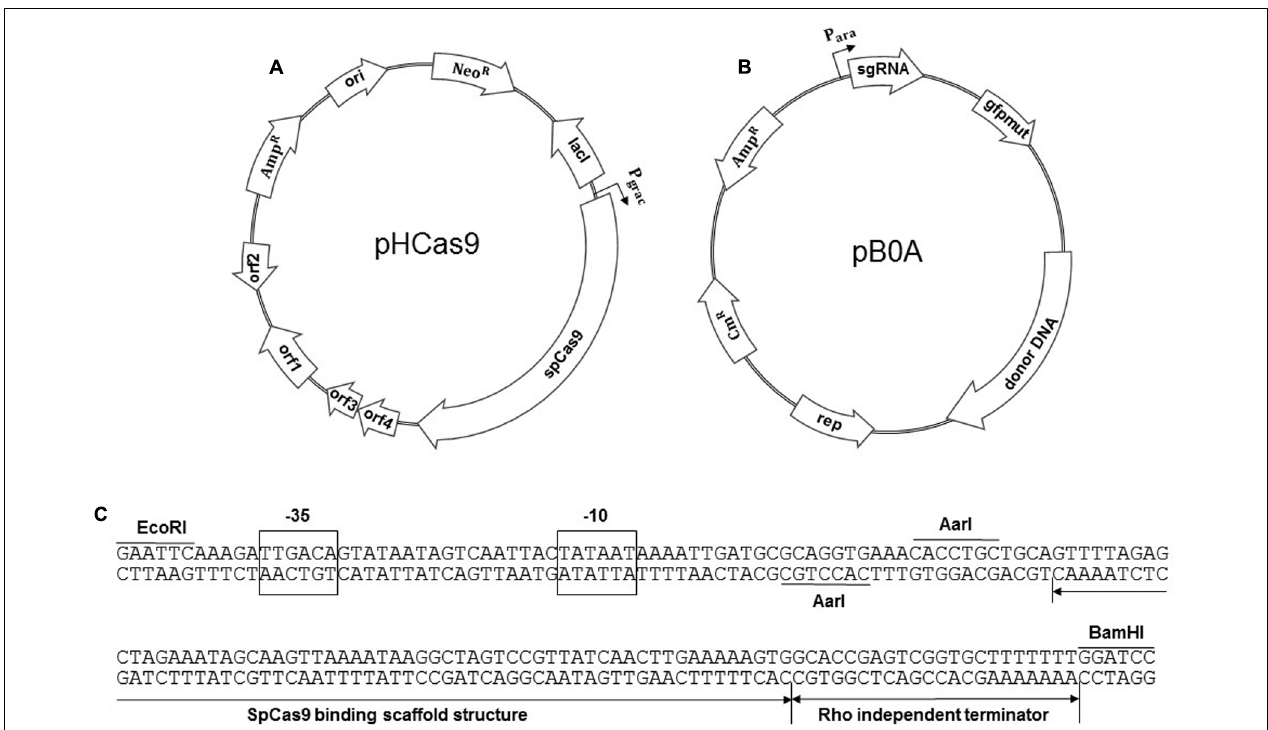
FIGURE 1 | Construction of the two plasmids for an iterative genome engineering system. (A) Maps of pHCas9 plasmid and (B) pB0A plasmid containing spo0A sgRNA transcription module as well as donor DNA template. (C) Sequence of a synthetic sgRNA module containing araABCD promoter, AarI sites for cloning of 20 bp gRNA sequence, SpCas9 binding scaffold and transcriptional terminator. The plasmids were deposited at Korean Collection for Type Cultures (KCTC) as KCTC 11628 (pHCas9) and KCTC 11629 (pB0A).